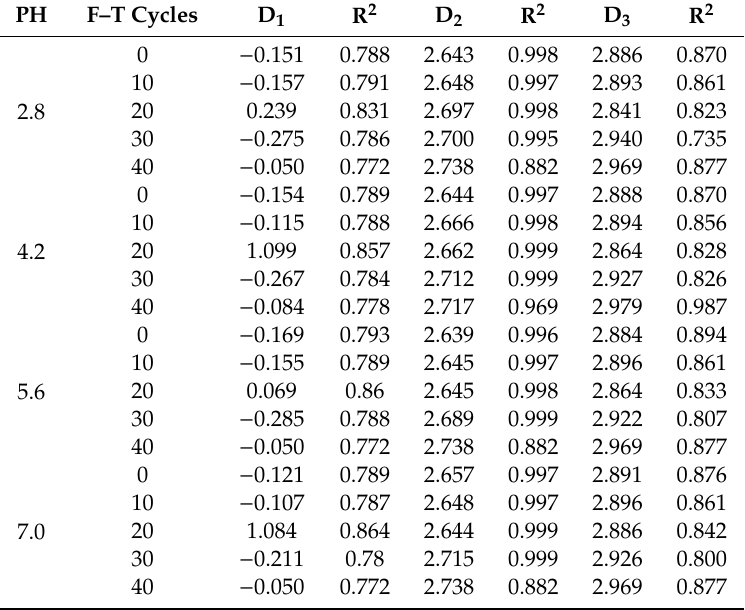
Table 2. Fractal dimensions of sandstone under di ff erent F–T cycles and acid solutions.